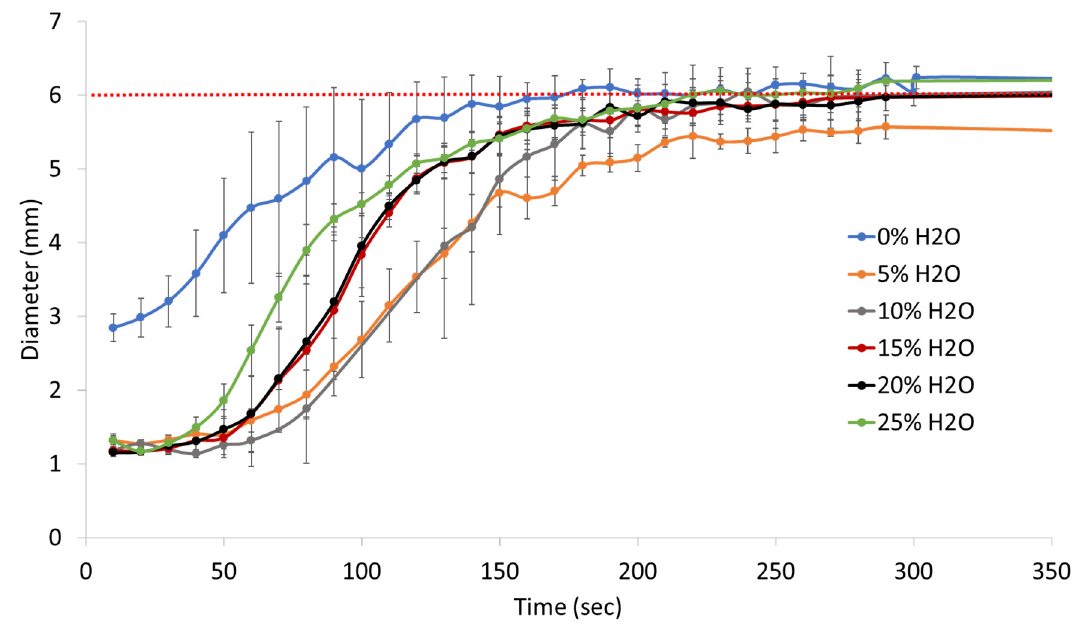
Figure 6. In vitro actuation profiles of SMP foams with varying water content in 37 °C water. The red dotted line indicates the original foam cylinder diameter of 6 mm.